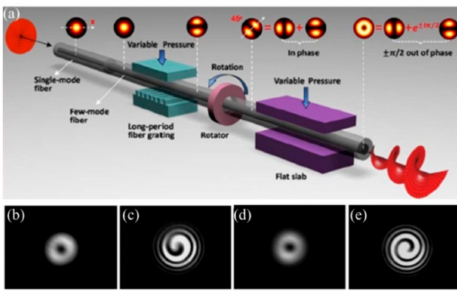
Figure 23. ( a ) Principle of the controllable all-fiber orbital angular momentum (OAM) mode converter. ( b , d ) intensity; and ( c , e ) interference pattern of the generated OAM ± 1 modes [51].